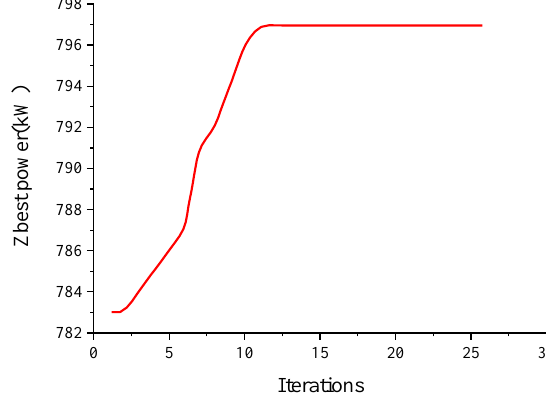
Figure 19. Evolution of particle swarm at low wind speed.